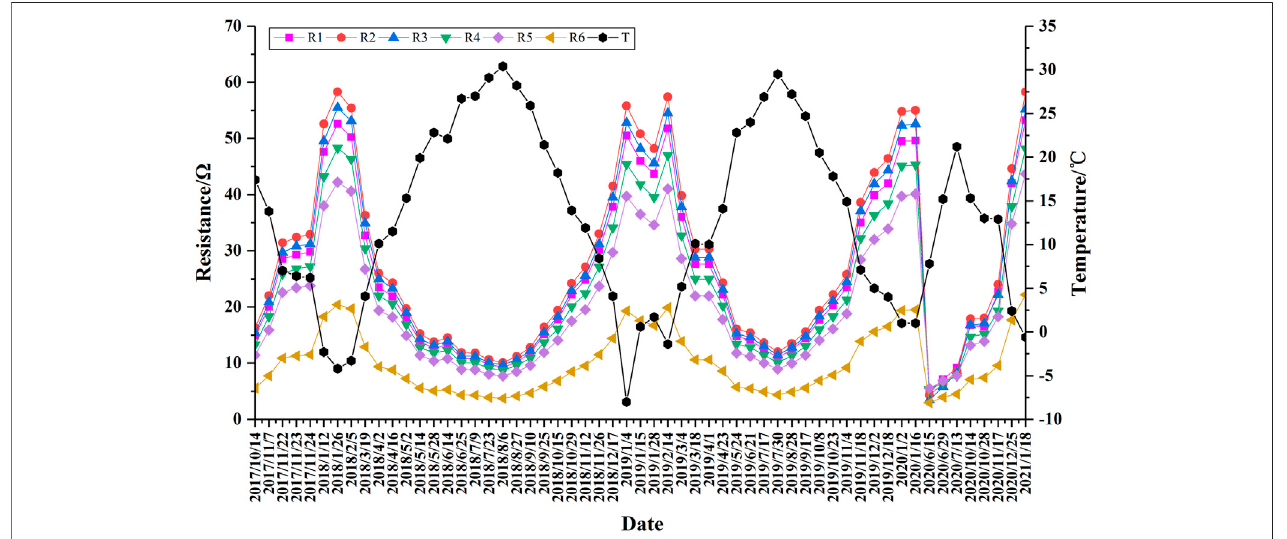
FIGURE 11 | Resistance between